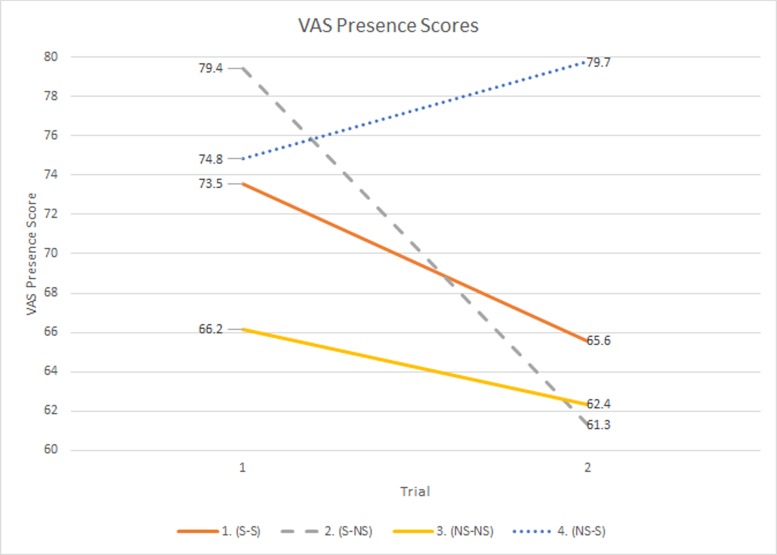
VAS Score by Trial.